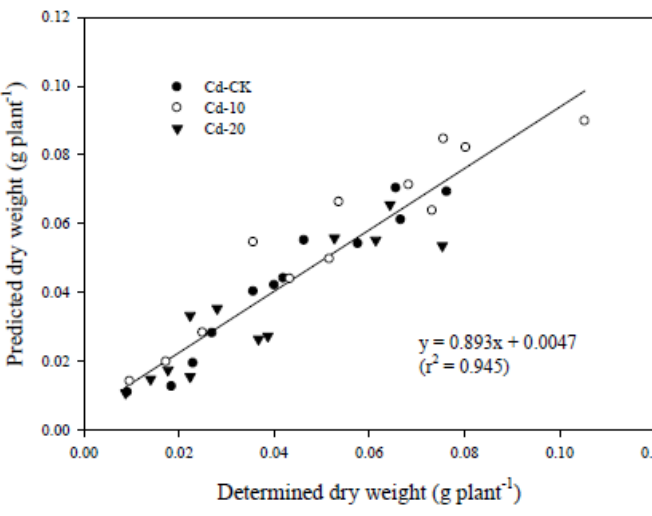
Figure 3. Linear relationship between the determined dry weight and the predicted dry weight of pak choi grown in various Cd-contaminated